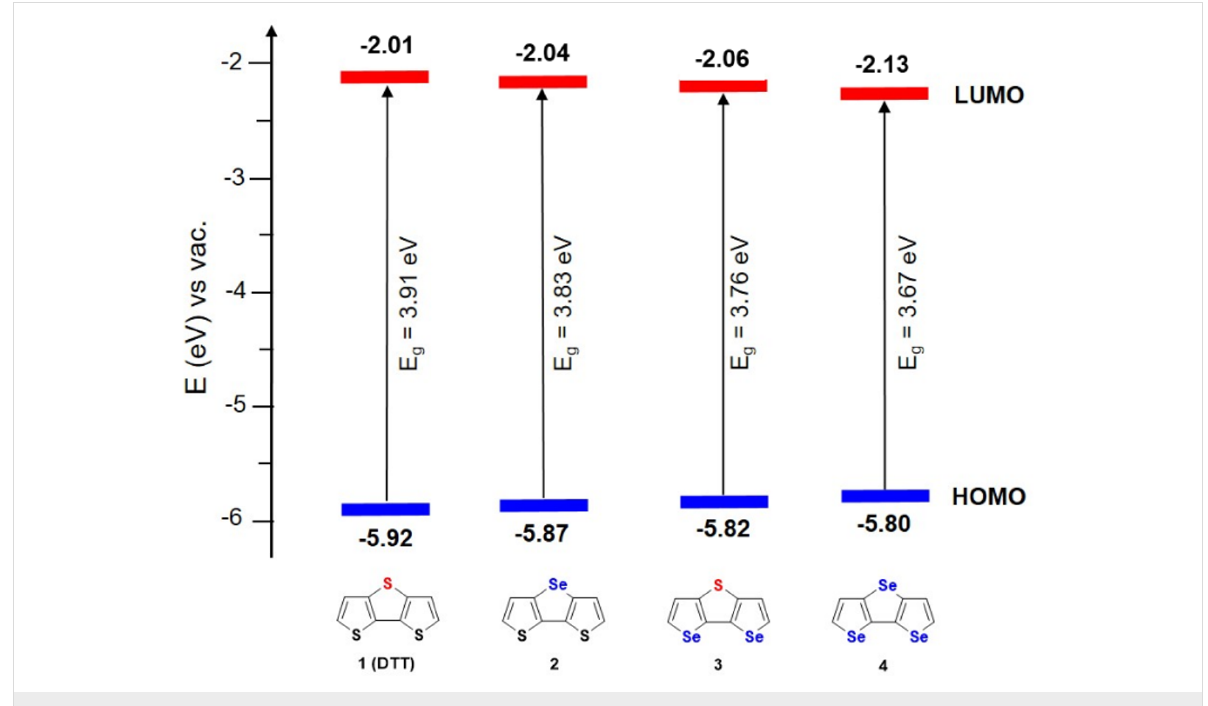
Figure 7: Energy diagram of the frontier molecular orbitals of heterotriacenes 1 – 4 .